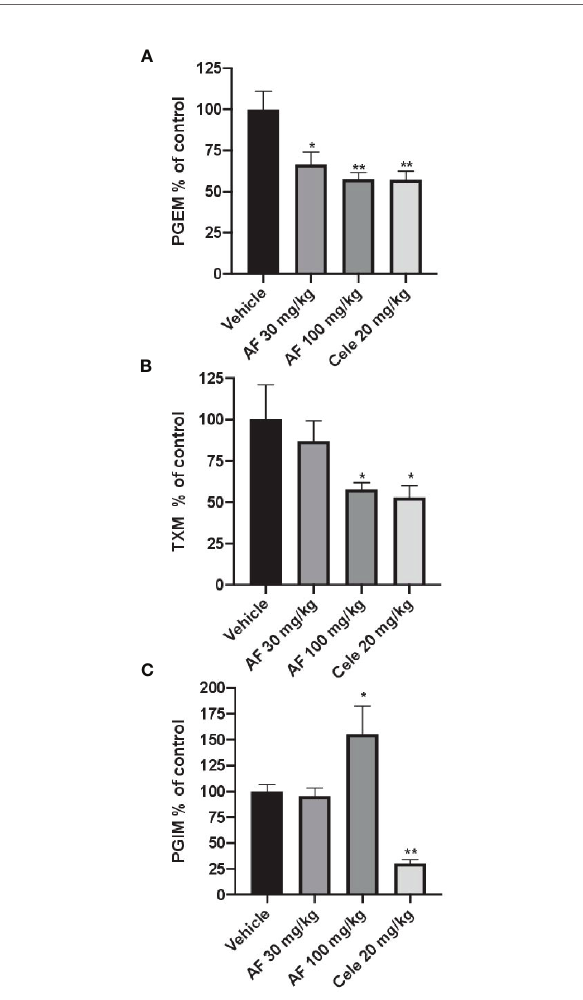
FIGURE 3 | Effects of AF3485 on the systemic biosynthesis of prostanoids in CFA-injected rats. Animals were chronically treated for 3 days with: i) vehicle (0.5% methylcellulose solution); ii) AF3485 30mg/kg, intraperitoneal (i.p.) (AF 30); iii) AF3485 100 mg/kg, i.p. (AF 100) and iv) celecoxib 20 mg/kg, i.p. (Cele 20). Urinary PGEM (A) , TXM (B) , and PGIM (C) , were assessed by LC-MS/ MS, corrected for urinary creatinine, and reported as % of control (vehicle). Values are reported as mean ± SEM (n=13 – 20) *P < 0.05, **P < 0.01 versus vehicle (One-way ANOVA and Student's t-test). CFA, complete Freund's adjuvant.